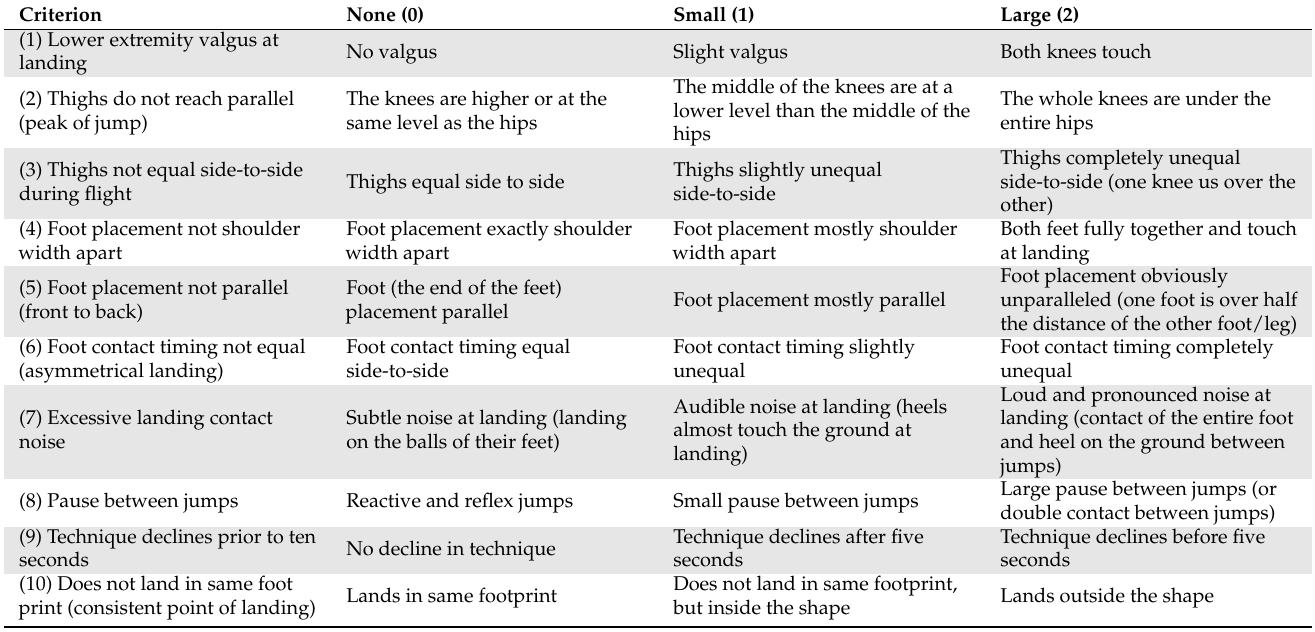
Table 2. Scoring criteria for each item of the Modified Tuck Jump Assessment